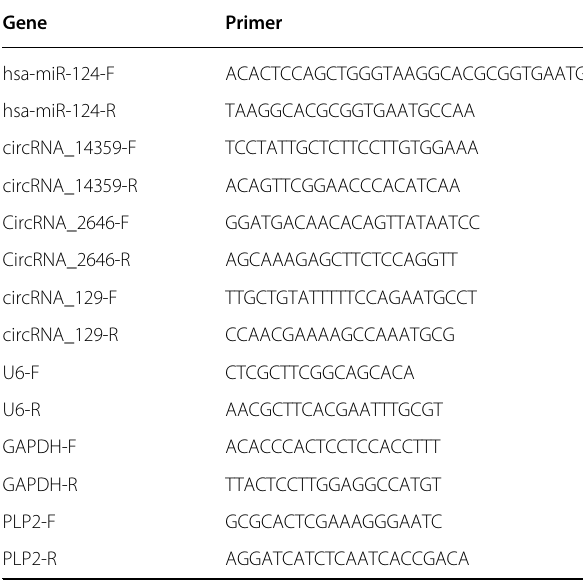
Table 2 Primers for different